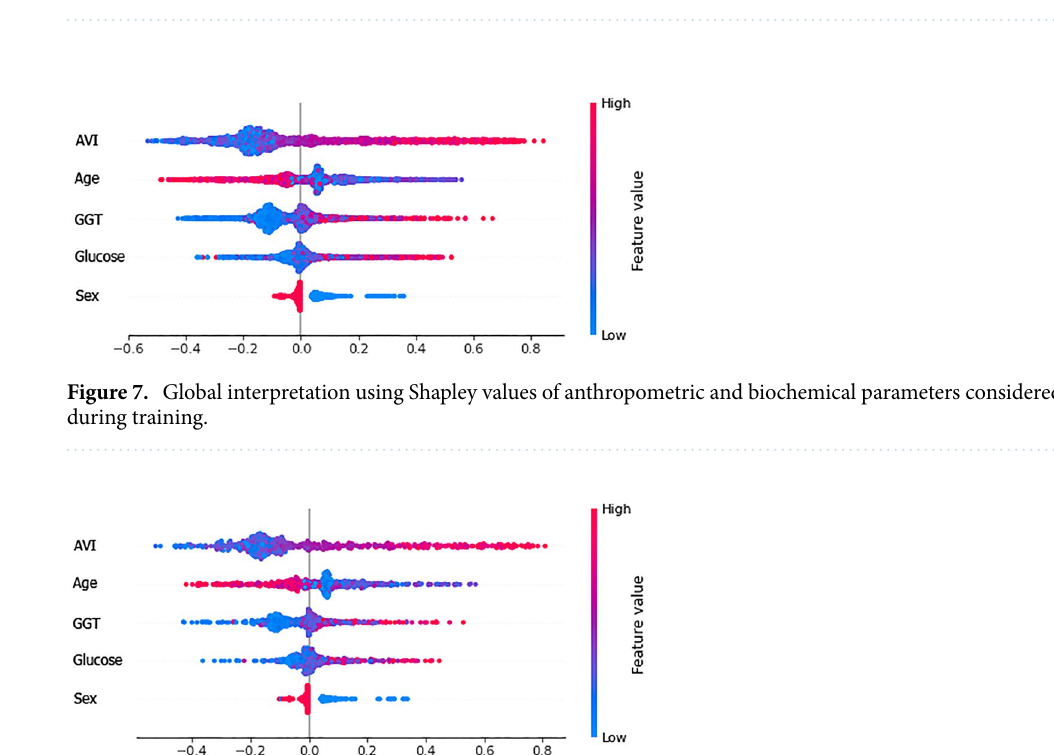
Figure 6. Histogram of feature relevance of anthropometric and biochemical parameters considered during test.